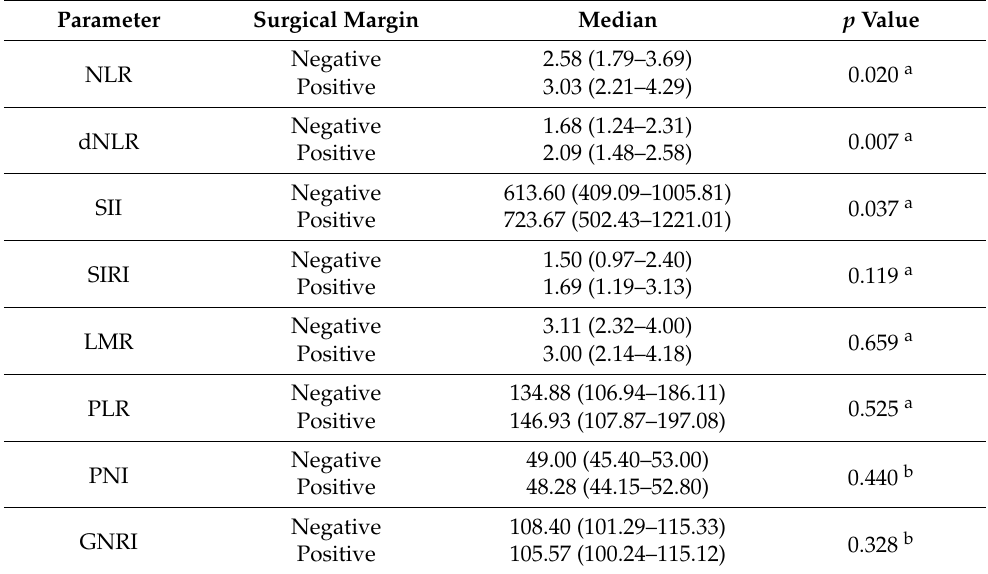
Table 7. Association of inflammatory and nutritional parameters with the status of surgical